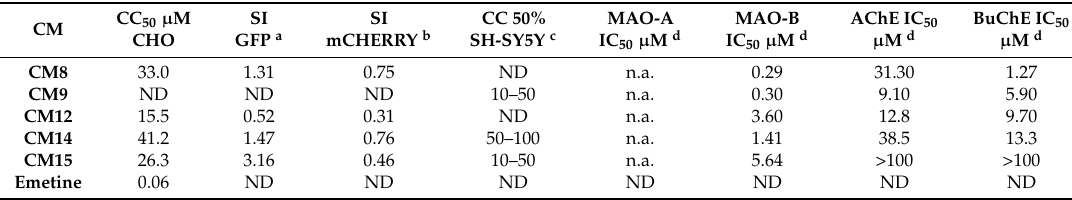
Table 4. 50% cell viability (CC 50 ) and selectivity indices on Chinese hamster ovary (CHO) cells, cell viability on SH-SY5Y cells and 50% enzyme inhibition (IC 50 ) of selected test